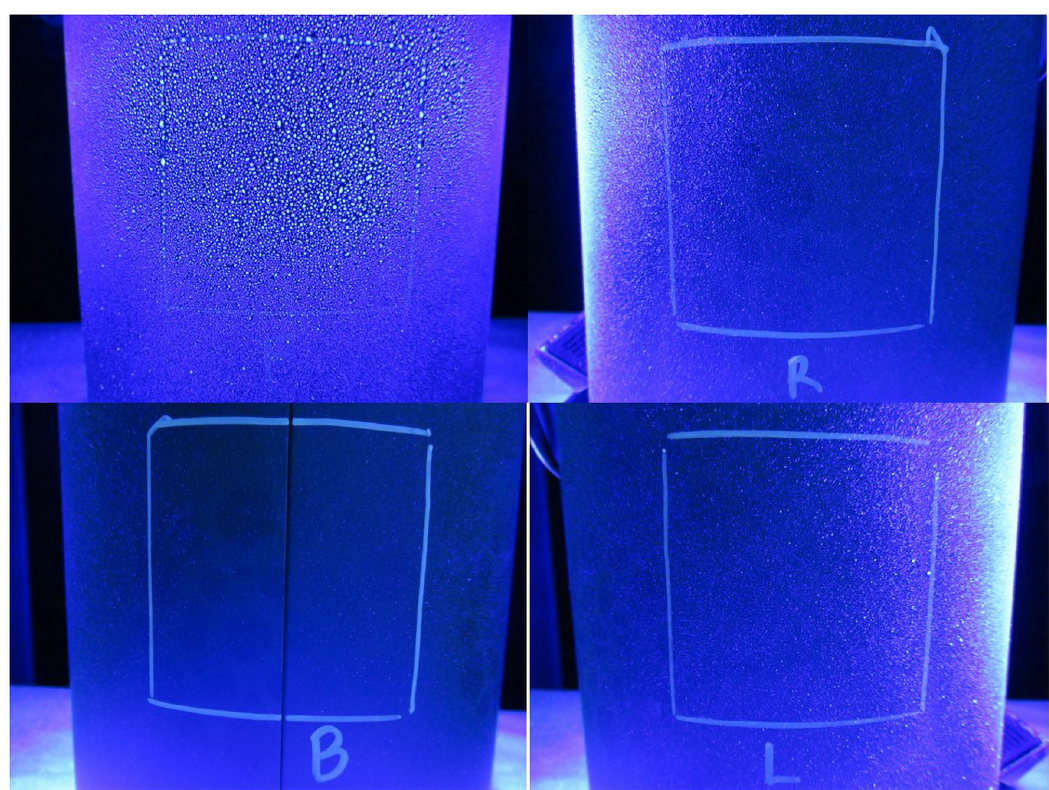
Fig 4. Example photographs for each quadrant of one of the sprayed trash cans. F = front of can (shown in upper left photo); R = right side of can; B = back of can; L = left side of can.